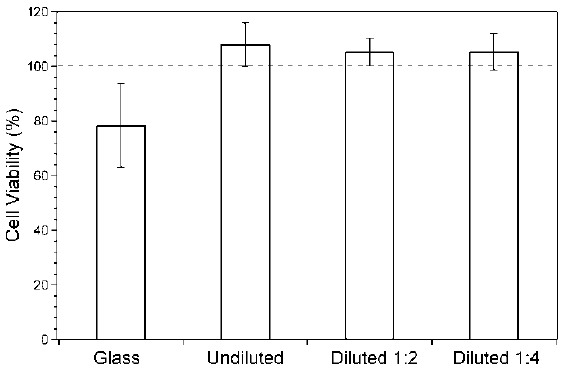
Figure 9. In vitro cytotoxicity of the CUC7 pentablock copolymer.